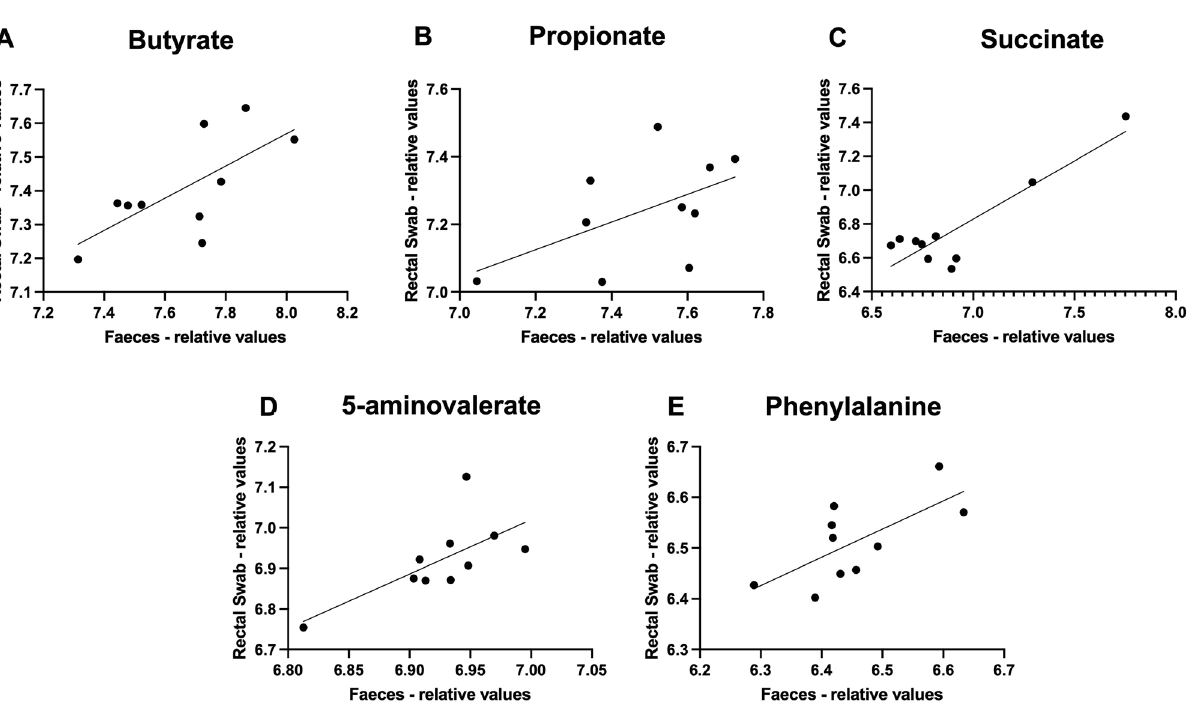
Figure 3. Correlation of levels of selected gut microbial-related metabolites in rectal swabs and matched stool samples. Performed using log transformed data with PQN normalisation. ( A ) Butyrate ( r = 0.6945, P = 0.0258; q = 0.105); ( B ) propionate ( r = 0.5298, P = 0.1152; q = 0.3456); ( C ) succinate ( r = 0.8945, P = 0.0005; q = 0.00525); ( D ) 5-aminovalerate ( r = 0.6816, P = 0.003; q = 0.105); ( E ) phenylalanine ( r = 0.6877, P = 0.0279; q = 0.105). Faeces: n = 10 samples; swabs: n = 10